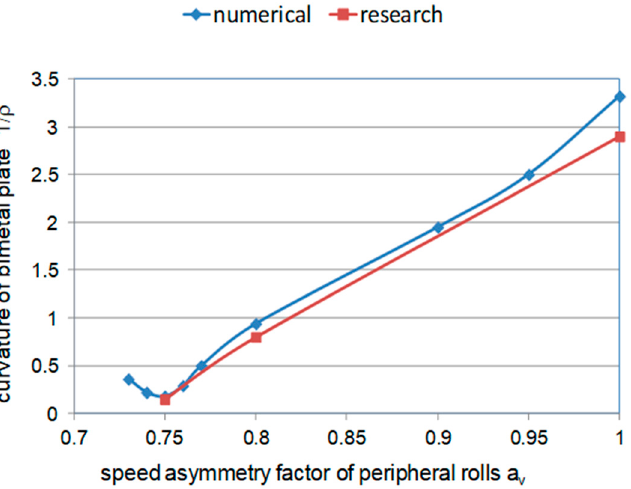
Figure 6. Relationship of the bimetallic sheet metal curvature on the kinetic asymmetry coefficient of the work rolls a v for the deformation ε = 0.18.